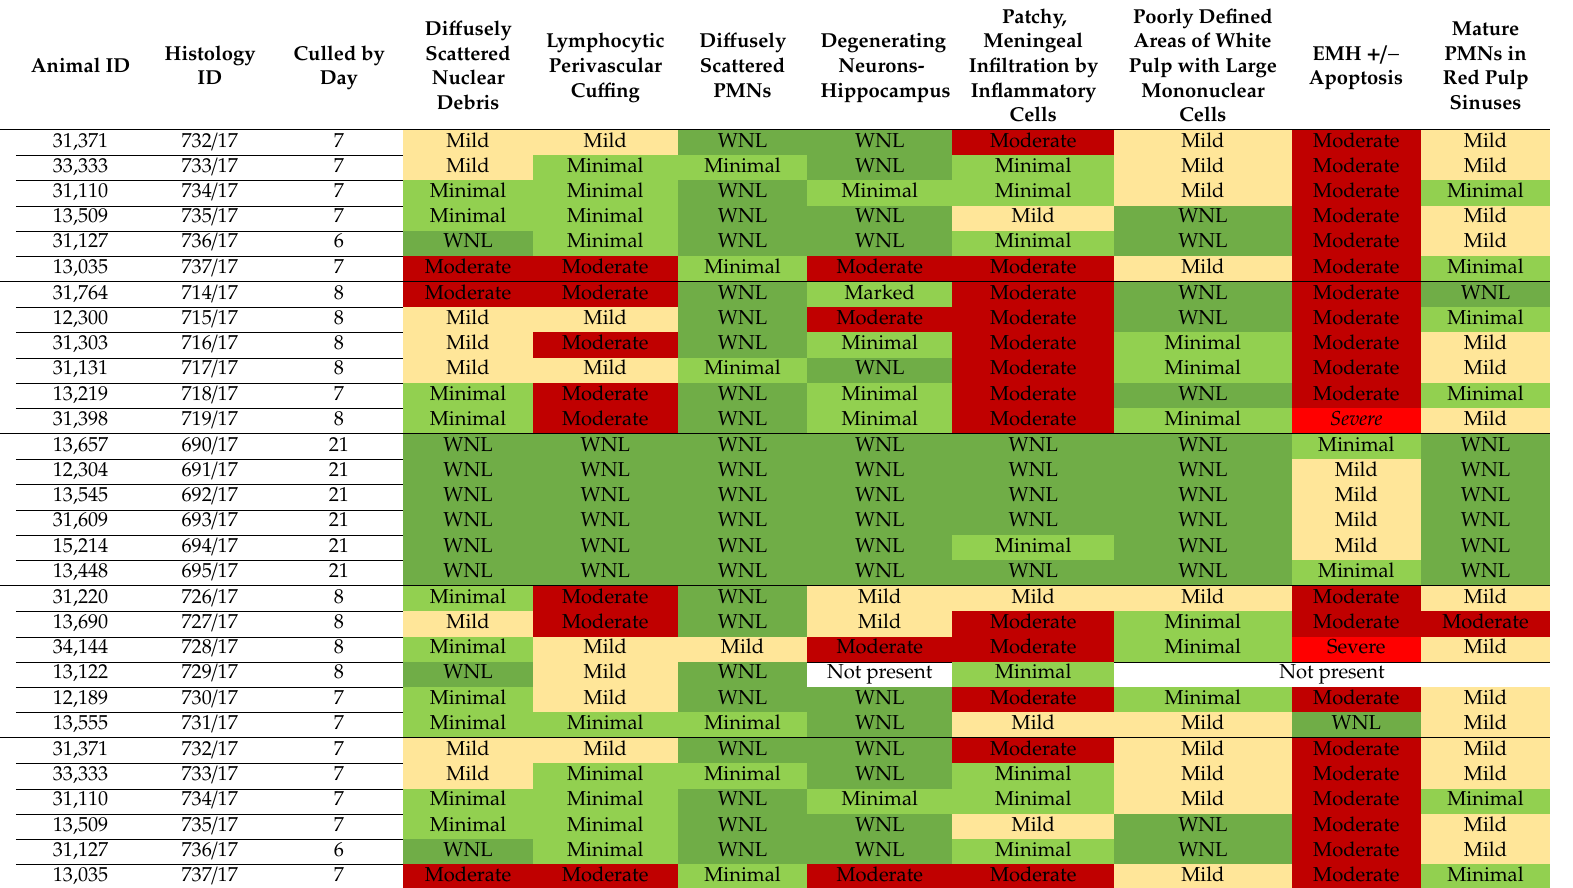
Table 1. Histology analysis in immunized A129 mice after ZIKV